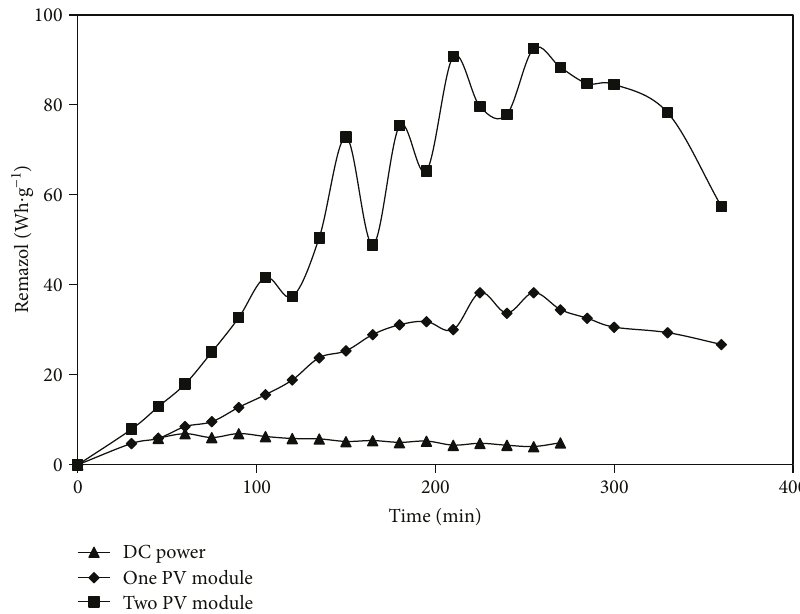
Figure 8: Comparison between CD and PV